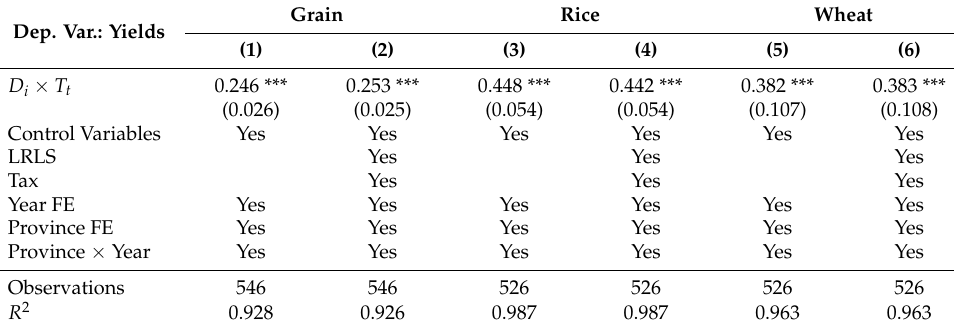
Table 7. The PSM-DD